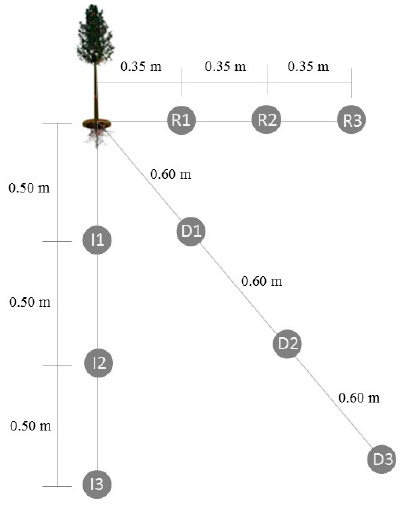
Figure 1. Representation of sampling design used for each representative tree. Area shown represents approximately a quarter of tree area (based on spacing). R : indicates row positions; I : indicates inter-row positions; and D : indicates diagonal positions at 45° between row and inter-row.